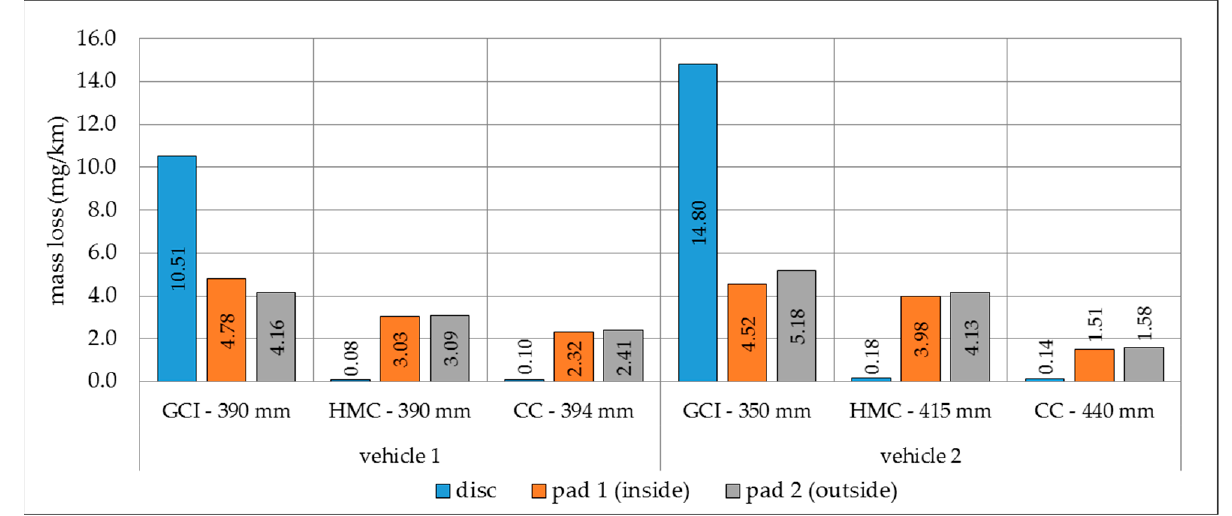
Figure 11. Comparison of different friction materials in terms of mass loss (Vehicles 1 and 2)—WLTP brake cycle trip #10.